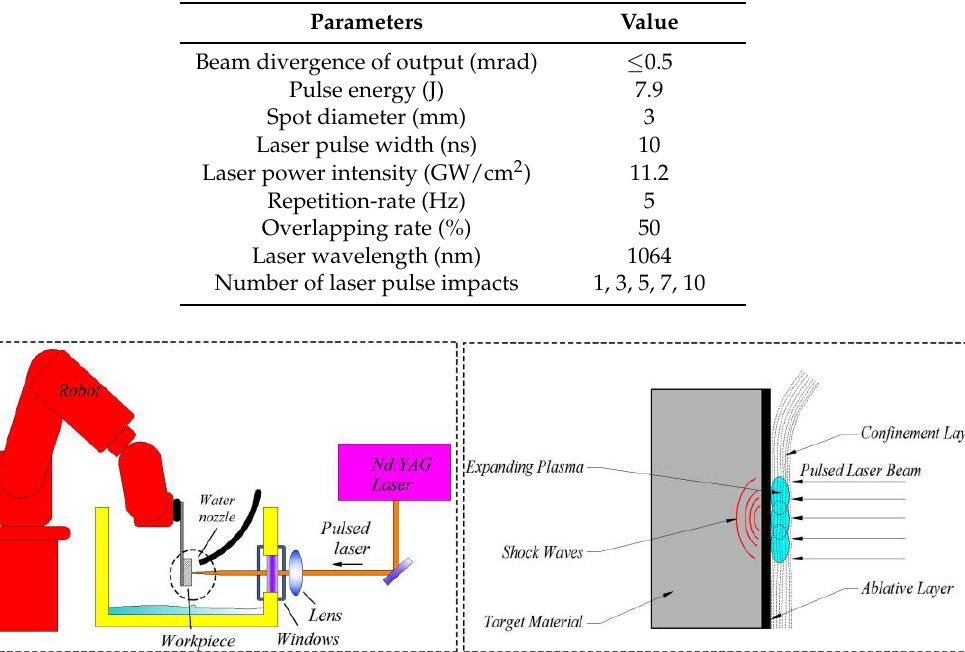
Figure 1. A schematic illustration of LSP.